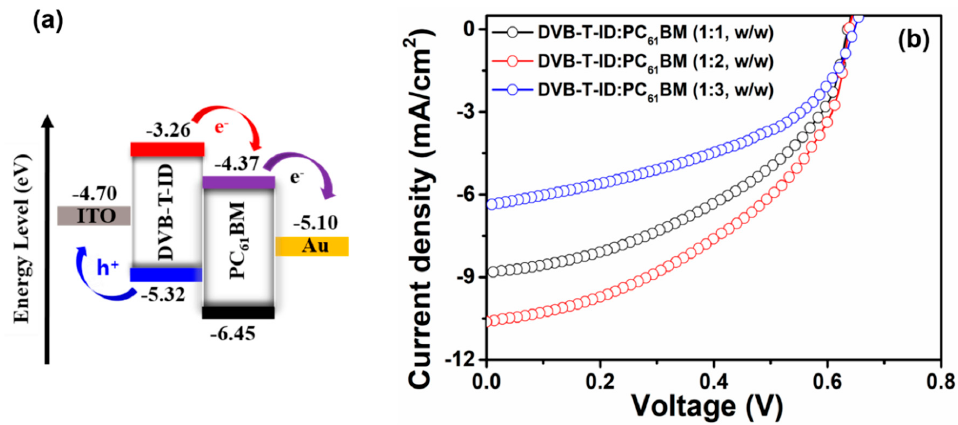
Figure 5. ( a ) Band structure of BHJ-OSC and ( b ) J-V curves of fabricated BHJ-OSCs with an active layer of DVB-T-ID:PC 61 BM of blend ratios 1:1 and 1:2 ( w / w ).